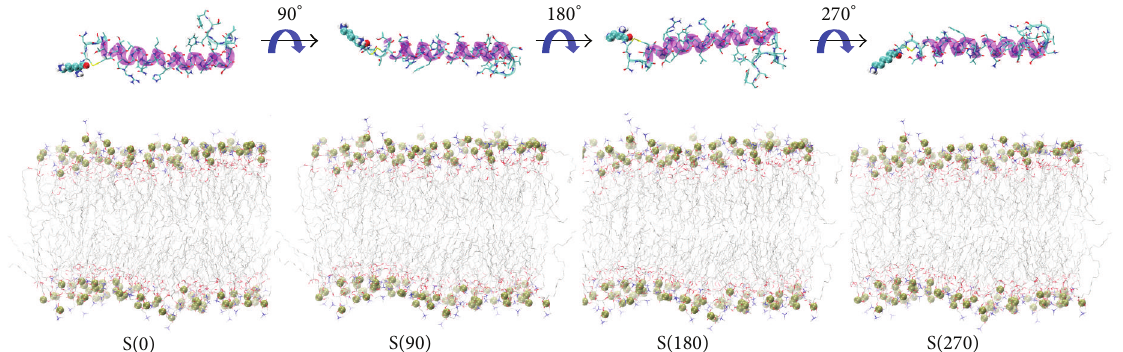
Figure 1: Four different initial states of simulated hIAPP-POPC systems. The side chain of residue K1 in S(0) points toward the POPC membranesurface.TheotherorientationsofhIAPParegeneratedbyrotatingthehIAPPhelixin(a)by90 ∘ ,180 ∘ ,and270 ∘ aroundthehelixaxis. The other three different initial states are labeled as S(90), S(180), and S(270), according to the rotation angle. The peptide is shown in cartoon representation, with the helix (residues 5–28) in purple, the coil in orange and the other secondary structure in cyan. Bond representation is given for each amino acid residue, except for K1 in van der Waals (vdW) representation. The lipids are shown in grey line representation and phosphorus atoms as tan spheres. For clarity, counterions and water molecules are not